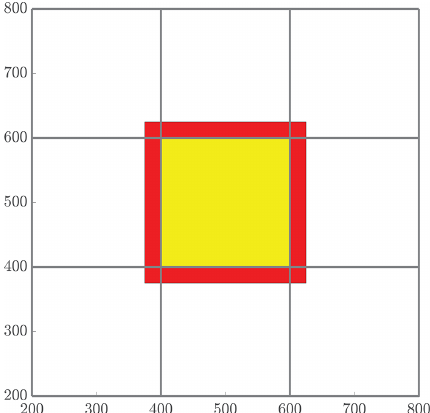
Figure 5. The red band represents all particles that will be received by the local subdomain (yellow) from neighboring regions for mass transfer. The number N S quantifies the number of particles that are involved in the MT step of the algorithm, which is the combination of all particles whose positions are in either the red or yellow region.